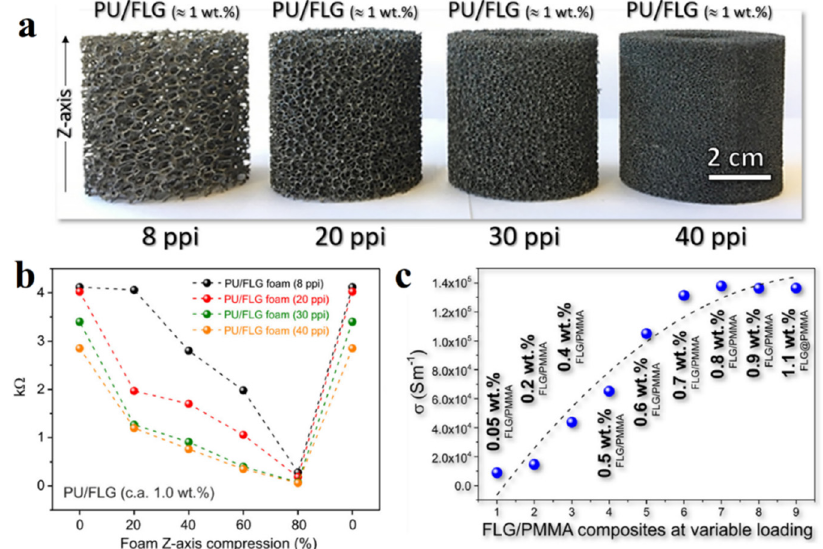
Figure 13. ( a ) Photos of composites FLG/PU ~1 wt.% with different hole values; ( b ) dependence of the FLG/PU sponge resistance on the degree of its deformation; ( c ) the change in the FLG/PMMA electrical conductivity of the composite in dependence with the coating/drying cycles. Reprinted with permission from